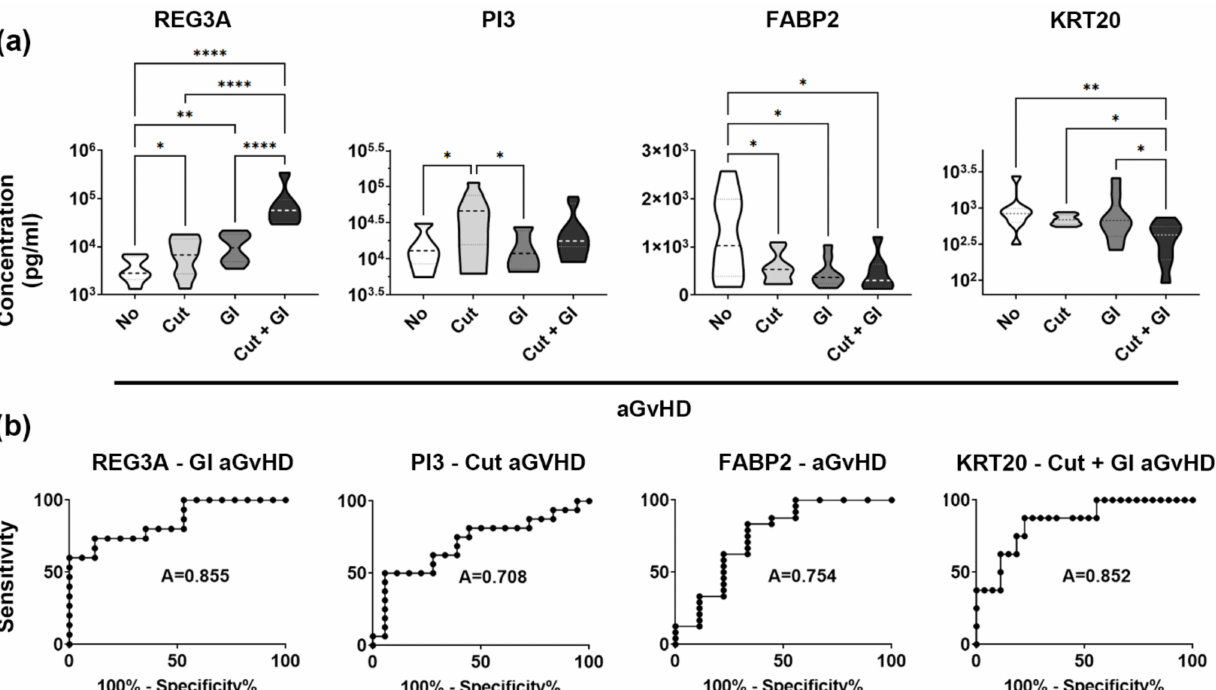
Figure 2. Plasma levels, sensitivity, and specificity of established and emerging tissue-restricted aGvHD biomarkers in comparison with KRT20. ( a ) REG3A, PI3, FABP2, and KRT20 protein concen- tration in the blood plasma of four aHSCT patient groups ( n = 10 each) affected by distinct organ manifestations of aGvHD. Abbreviations: No, no aGvHD developed; Cut, cutaneous; GI, gastroin- testinal aGvHD. Protein levels were determined at the time of aGvHD diagnosis, using commercial ELISA assays (One-Way ANOVA, stars indicate results of post hoc tests; * p < 0.05, ** p < 0.01, **** p < 0.0001). ( b ) Sensitivity and specificity of the same four markers linked to the respective organ manifestations of GvHD (receiver operating characteristic, values indicate area under the